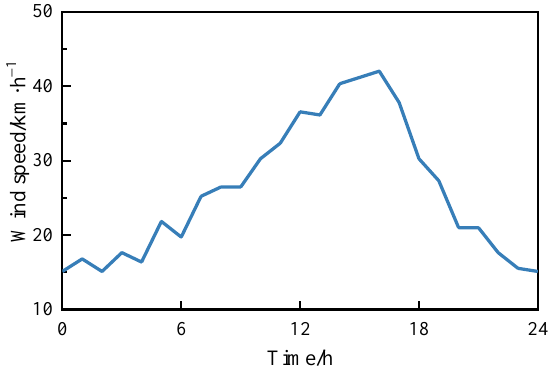
Figure 4. Daily wind speed curve.